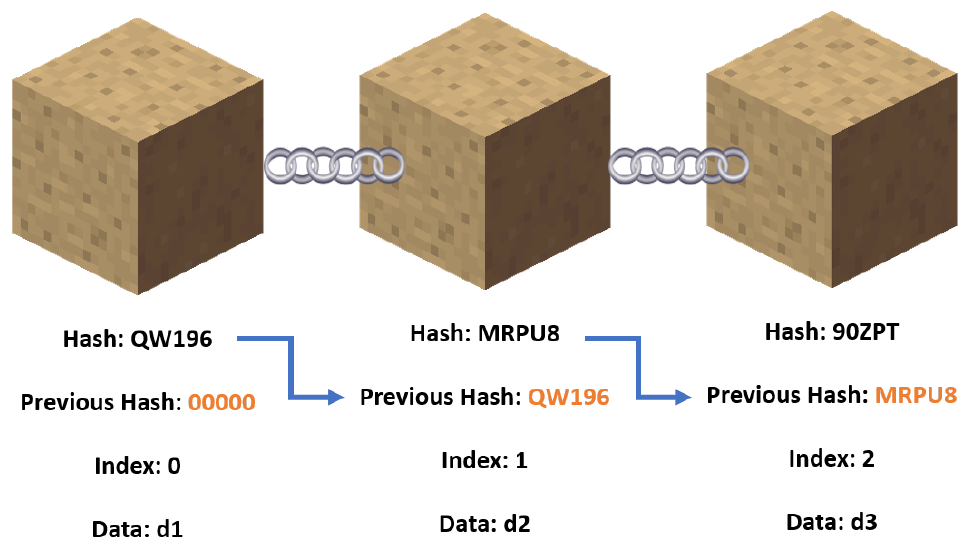
Figure 3. Pictorial representation of the Blockchain: To maintain the chain integrity, the preceding block’s hash must be located in the current block.